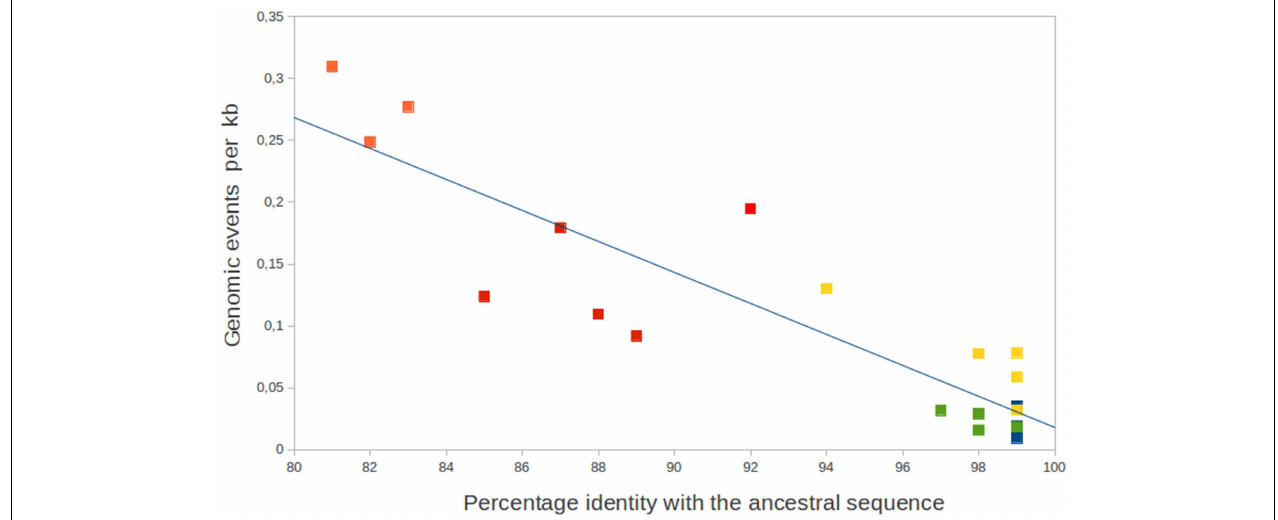
FIGURE 1 | Number of genomic events per kb for each GVs with respect to the percentage of nucleotide similarities of the four taxonomic genes with the ancestral sequences. GVs are represented